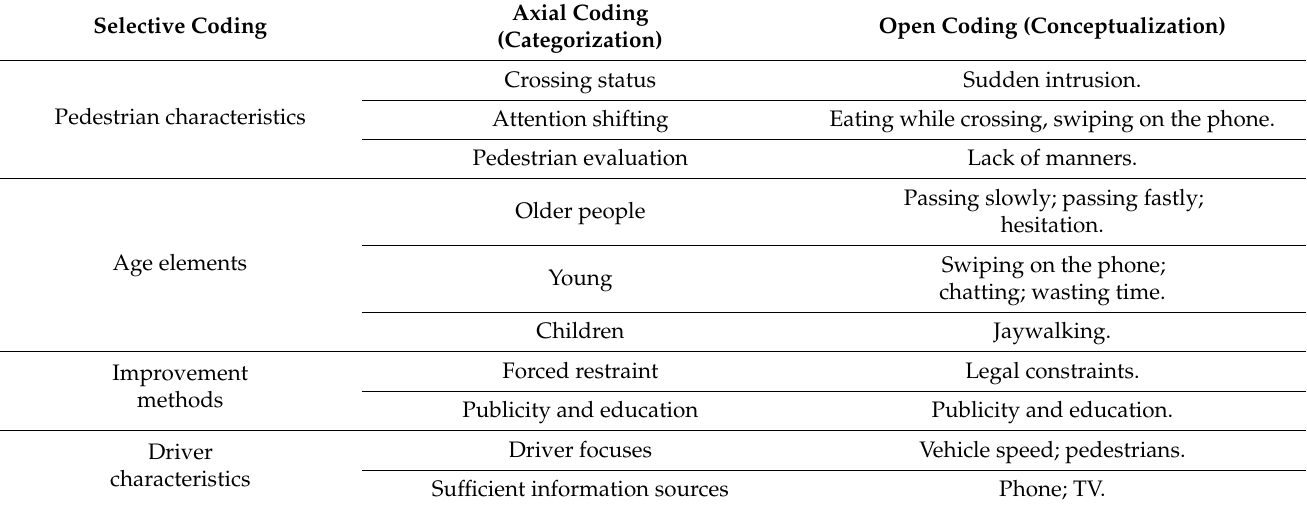
Table 5. Saturation